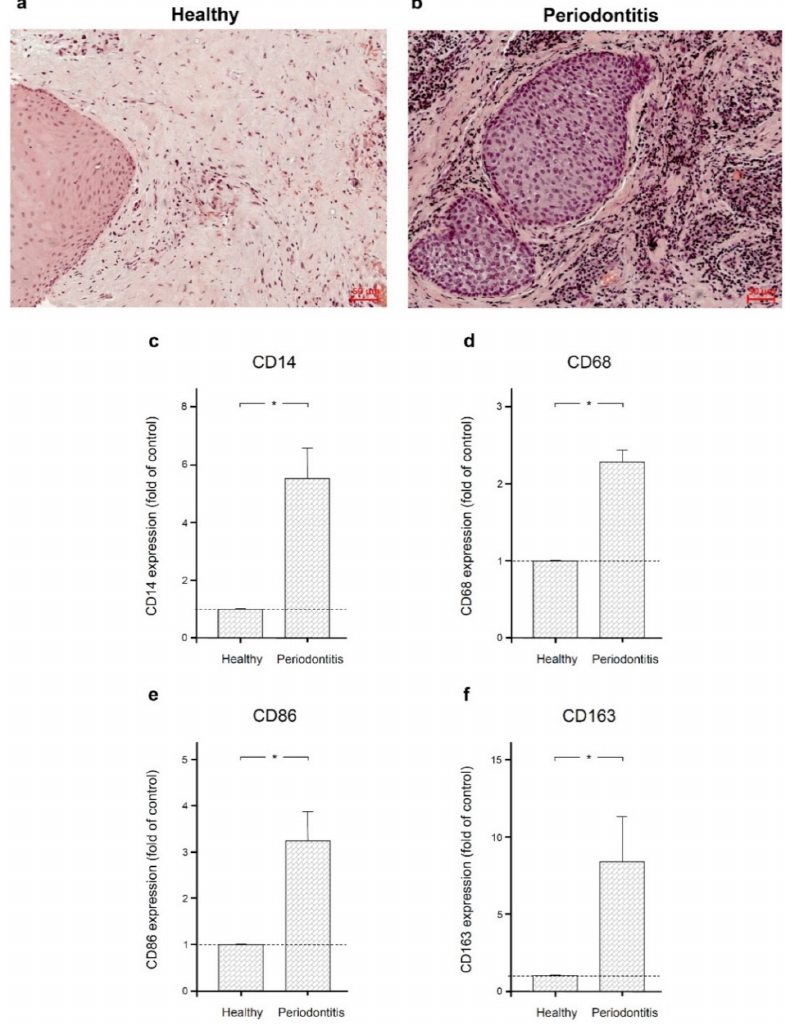
Figure 1. Gingival biopsies from periodontally healthy individuals and periodontitis patients. Gingi- val biopsies from a periodontally healthy individual ( a ) and a periodontitis patient ( b ). Representative histologic sections are shown. Expression of macrophage markers CD14 ( c ), CD68 ( d ), CD 86 ( e ), and CD163 ( f ) in gingival biopsies from six periodontally healthy subjects and six periodontitis patients. Bars show mean ± SEM. * significant ( p < 0.05) difference between